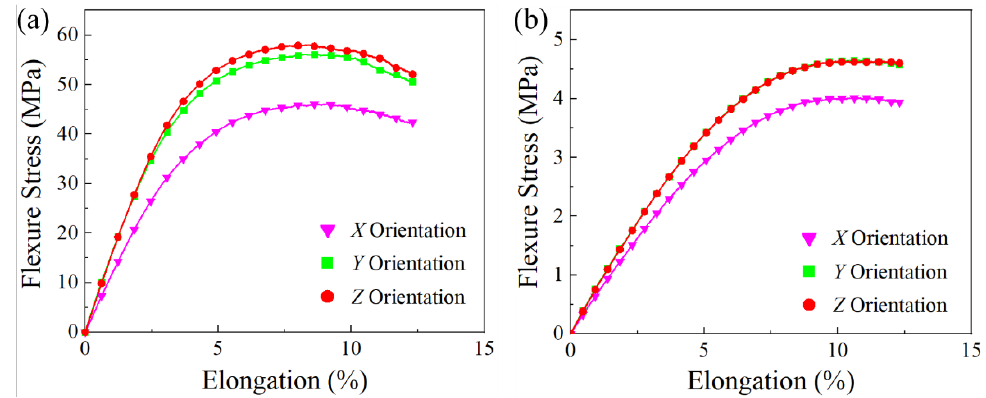
Figure 10. Stress – strain curves of flexural specimens: ( a ) PA11 and ( b ) TPU. Figure 10. Stress–strain curves of flexural specimens: ( a ) PA11 and ( b ) TPU. Table 6. Flexural properties of the PA11 and TPU specimens.